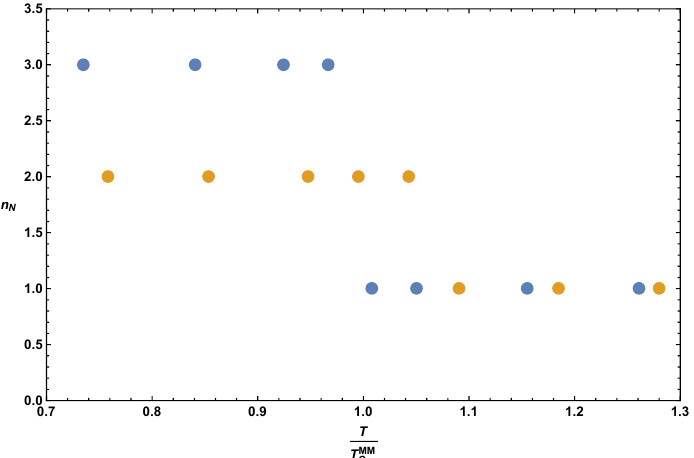
Figure 3: The finite N numerical topological index n is plotted against a dimension- N less temperature T / T MM for the same models as considered previously: blue dots C = − 3, v = 1 ) and yellow dots are ( v = 1 ) . Here, T MM are ( v is the transition 4 5 3 c temperature of the corresponding matrix integral. The total number of eigenvalues = 16800, which is the rank of the matrix ( N = 120) multiplied by twice the is N eff number of Monte Carlo sweeps (the factor of two comes from symmetrizing the dis- = η = ε tribution). We set ε (the value prescribed by the Freedman Diaconis N N FD rule) for both parameter sets and obtain estimates of T that are within 5% of the c true N → ∞